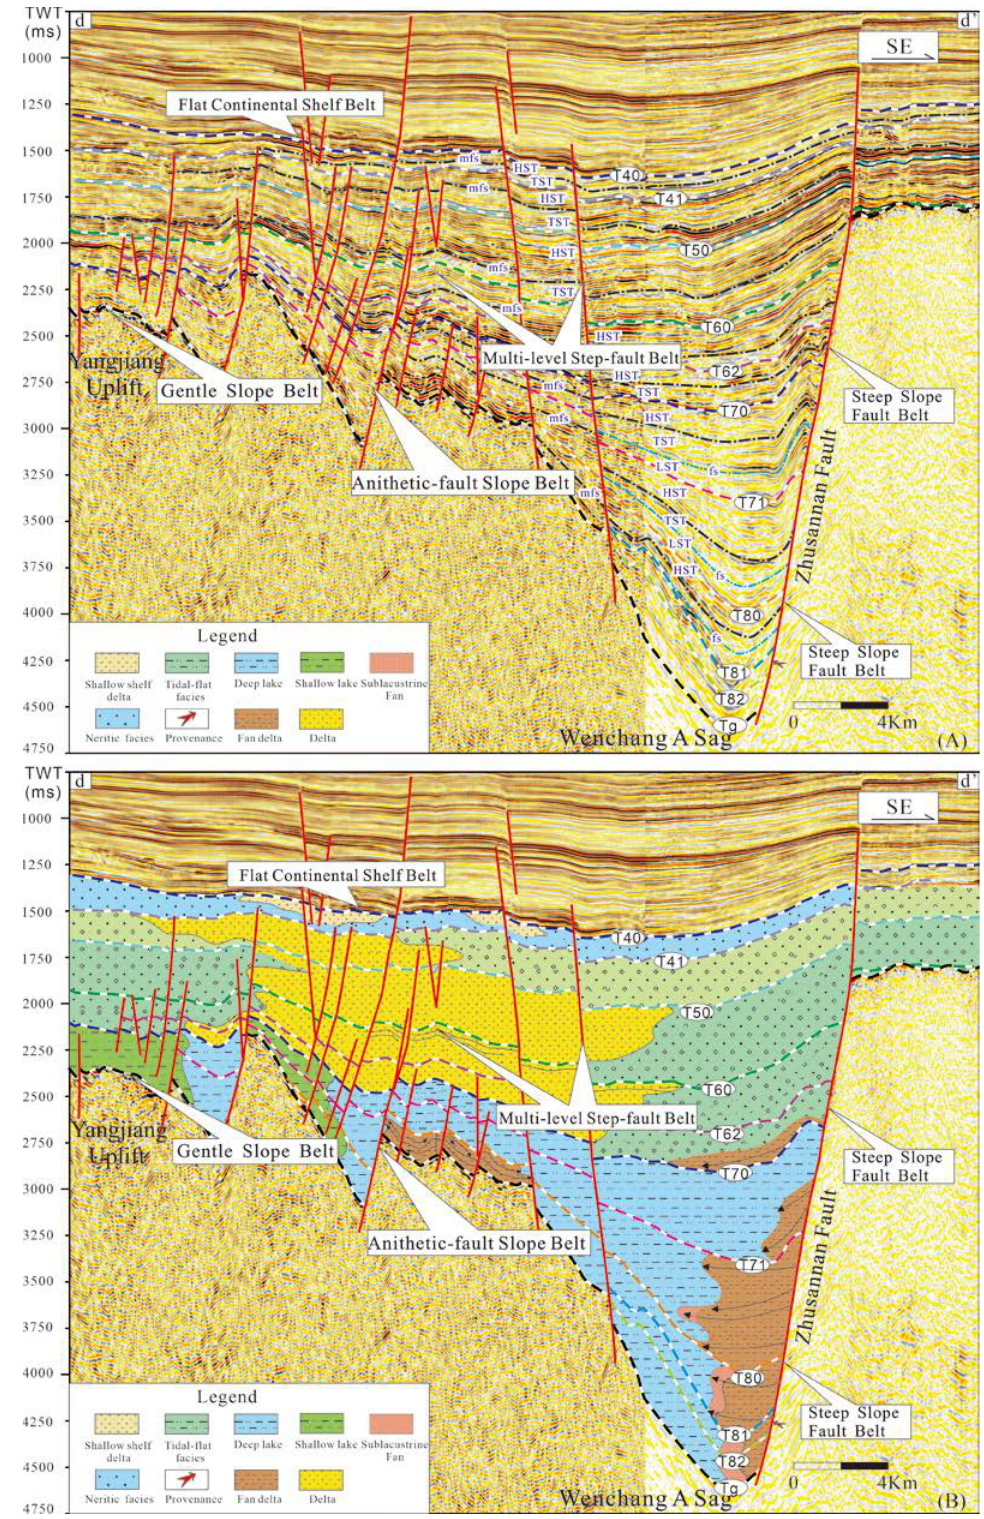
Figure 9. ( A ) interpreted seismic section dd’ showing seismic reflection characteristics and the distribution regions of different stratal stacking patterns; ( B ) the types of depositional facies and their distribution ranges in the section dd’ showing the depositional evolution from the Eocene to the Miocene. The location of section bb’ is shown in Figure 1.